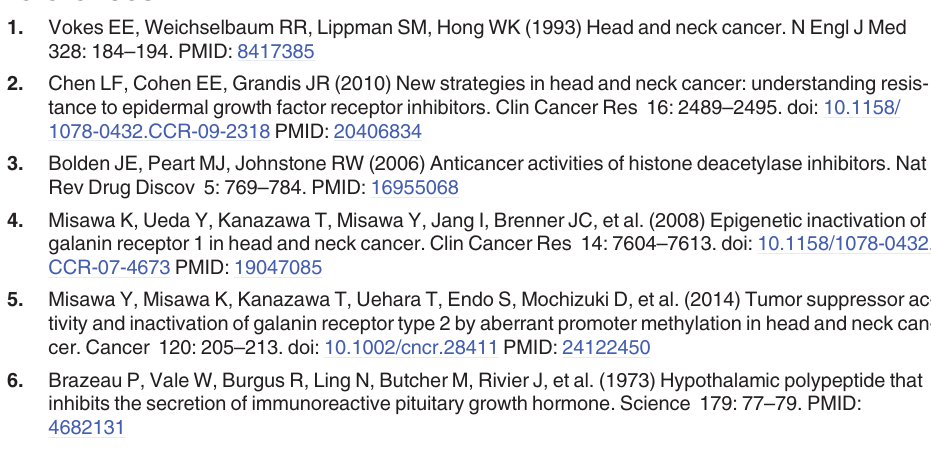
S1 Fig. Comparison of GMI among selected epidemiologic and clinical characteristics. GMI was calculated by taking the sum of gene promoter hypermethylation events (eight in this study; p16 , RASSF1A , E-cadherin , H-cadherin , MGMT , DAPK , DCC , and COL1A2 ). (EPS) S2 Fig. Kaplan-Meier survival curves for patients with HNSCC. Disease-free survival by (A) TAC1 and SSTR1 methylation status, (B) galanin and SSTR1 methylation status, (C) GALR2 and SSTR1 methylation status, and (D) GALR1 and SSTR1 methylation status. Blue line, pa- tients without methylation; red line, patients with methylation. S3 Fig. Odds ratios for recurrence based on multivariate logistic-regression adjusted for GMI (6 – 8 vs. < 6), age (65 and older vs. < 65), sex, alcohol exposure, and smoking status. S4 Fig. Diagrammatic representation of SST and SSTRs expression analysis by quantita- tive-RT-PCR in UM-SCC cell lines and normal oropharyngeal samples (NOS). S1 Table. SST and SSTR1 genes methylation status in HNSCC primary samples. This is cor- relation with p16 , RASSF1A , E-cadherin , H-cadherin , MGMT , DAPK , DCC , and COL1A2 methylation